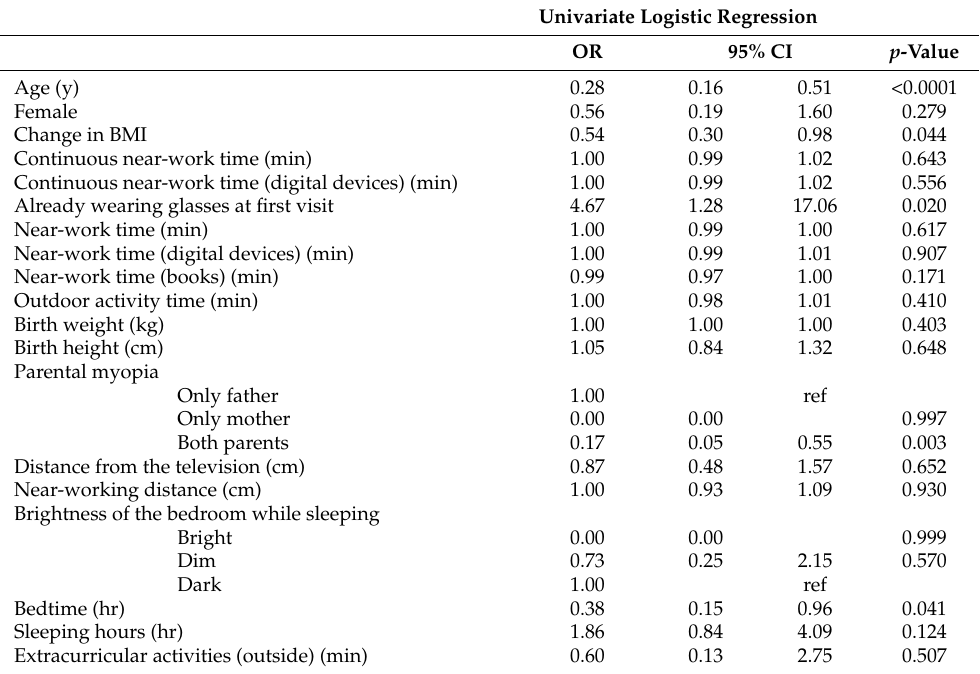
Table 3. Factors for increase in axial length of 1.2 mm or more.